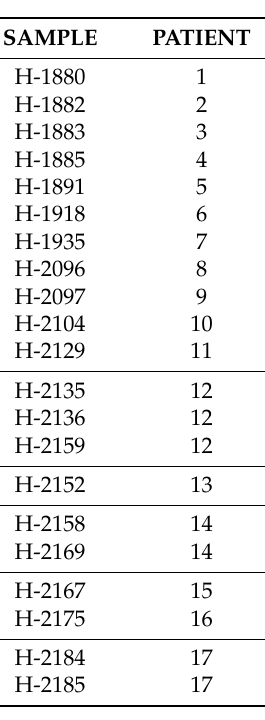
Table 1. A. fumigatus TRESPERg genotypes of isolates obtained from patient samples and their location at the